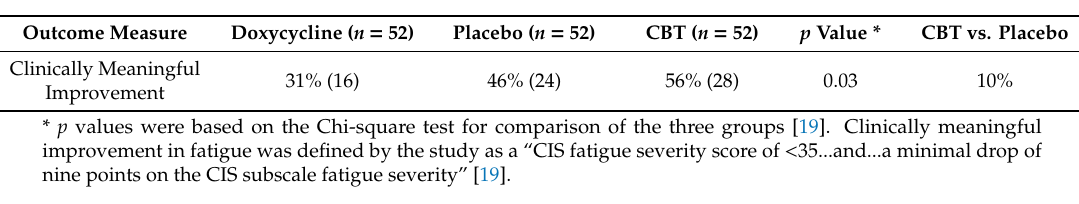
Table 3. Percentage of participants with a clinically meaningful improvement in fatigue at the end of treatment.